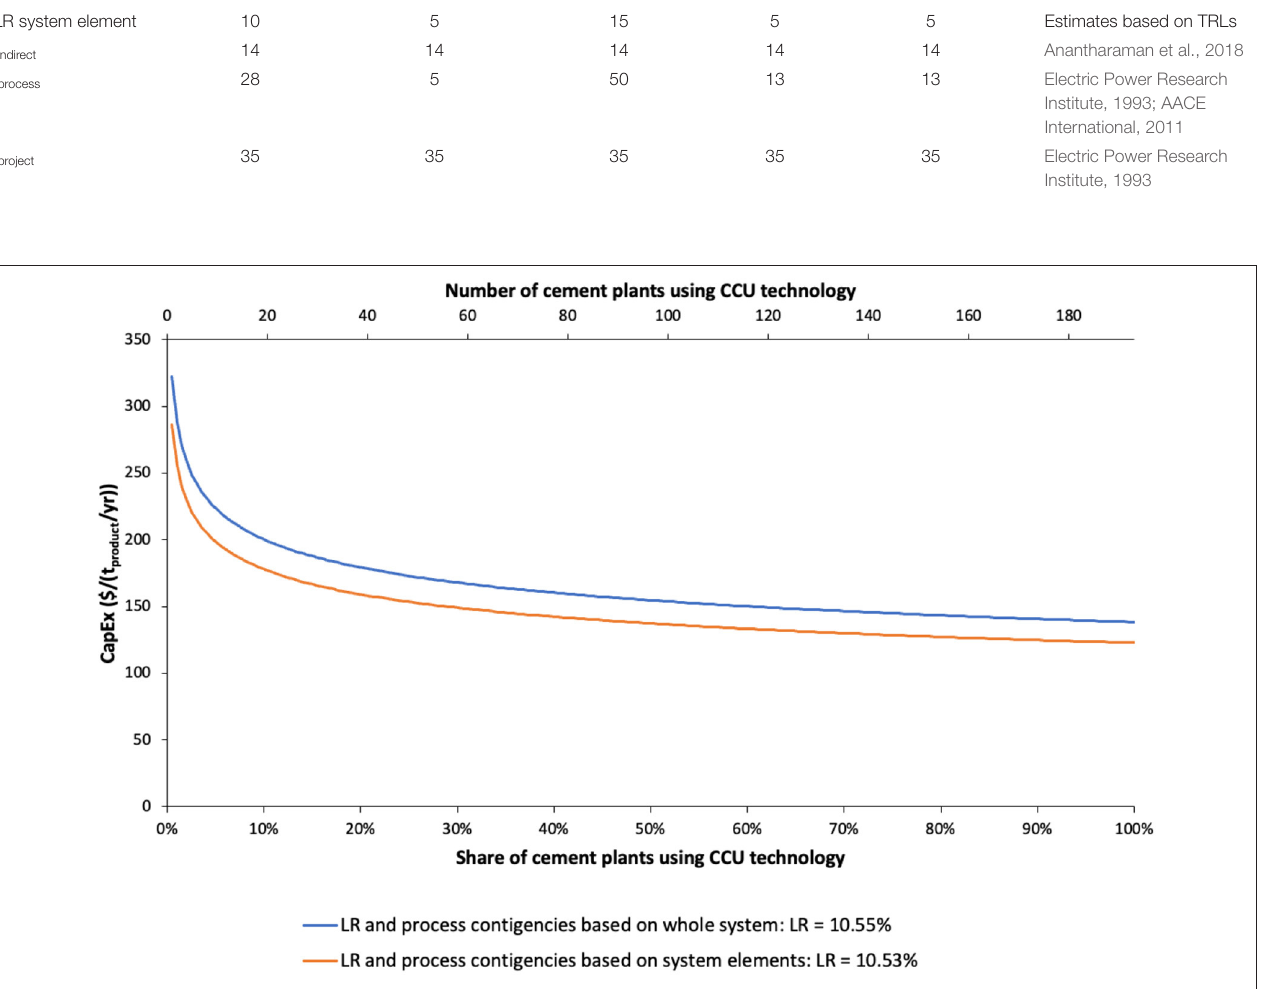
FIGURE 2 | Technology learning curve for mineralization capital costs. FOAK costs differ due to differences in how process contingencies are calculated. Total number of cement plants in Western Europe is 193 (100%) (see text footnote